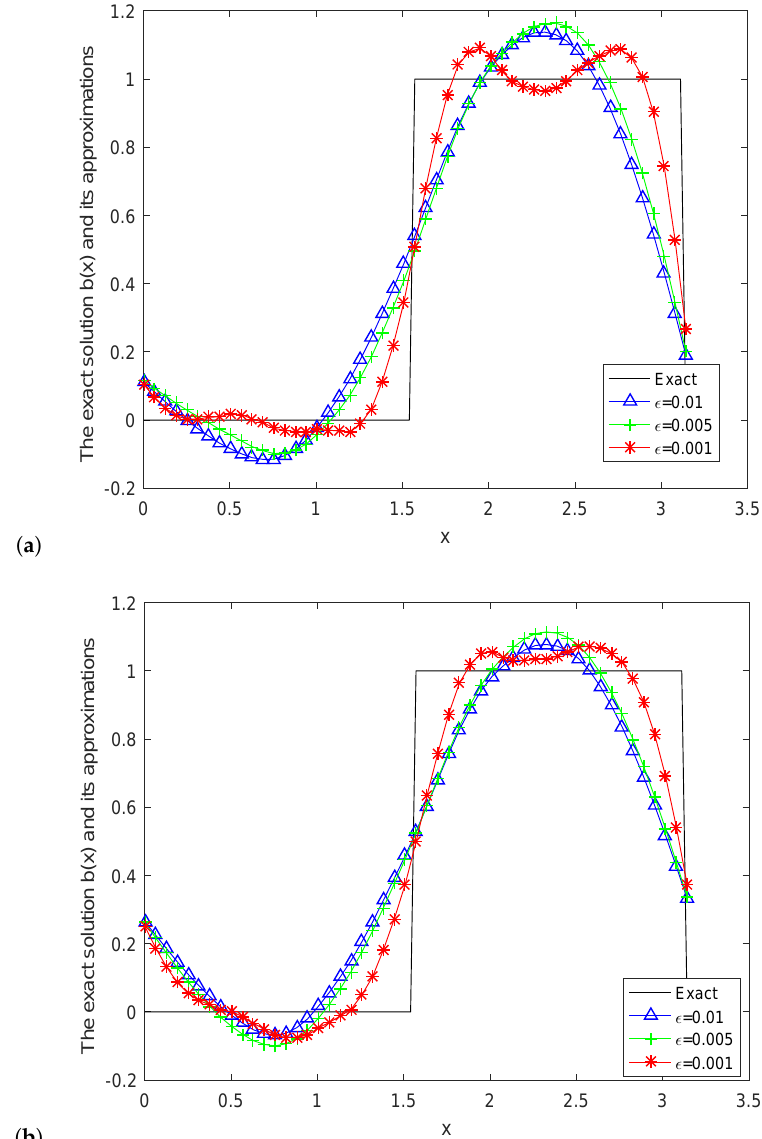
( x ) for Instance 6: ( a ) α = 1.2, N 2